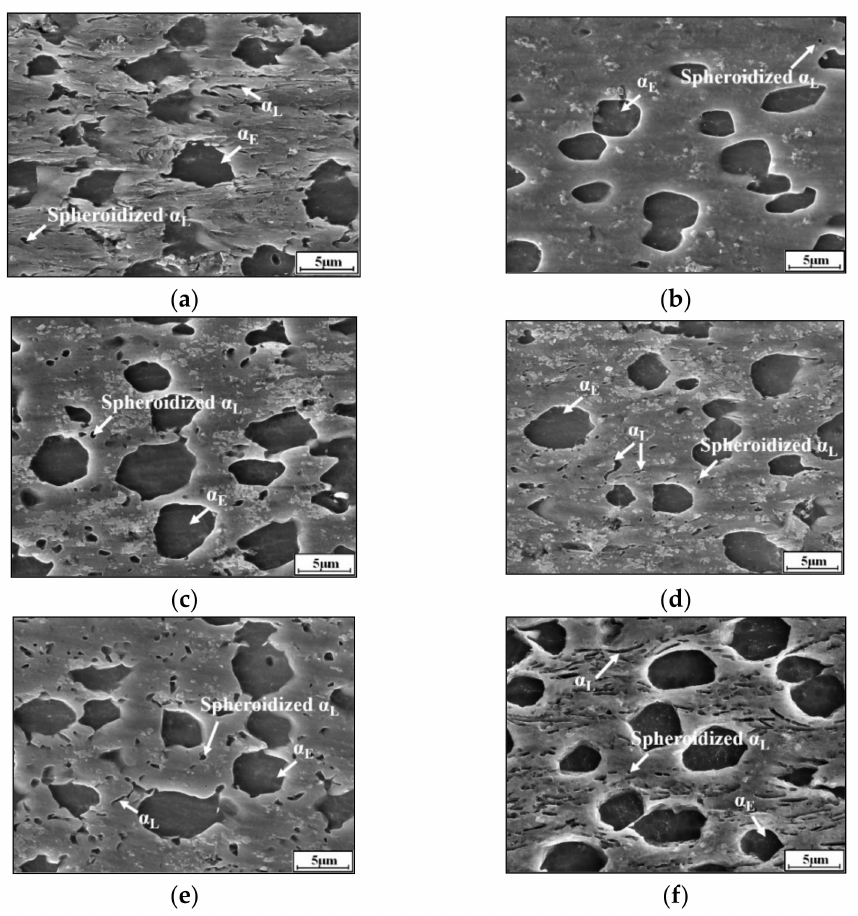
Figure 3. SEM images of Ti-55511 compressed at: ( a ) 973 K–0.1 s − 1 –0.3–0.001 s − 1 ; ( b ) 1033 K–0.1 s − 1 –0.3–0.001 s − 1 ; ( c ) 1003 K–0.1 s − 1 –0.2–0.001 s − 1 ; ( d ) 1003 K–0.1 s − 1 –0.5–0.001 s − 1 ; ( e ) 1003 K–0.1 s − 1 –0.3–0.01 s − 1 ; ( f ) 1003 K–0.1 s − 1 –0.3–1 s − 1 .